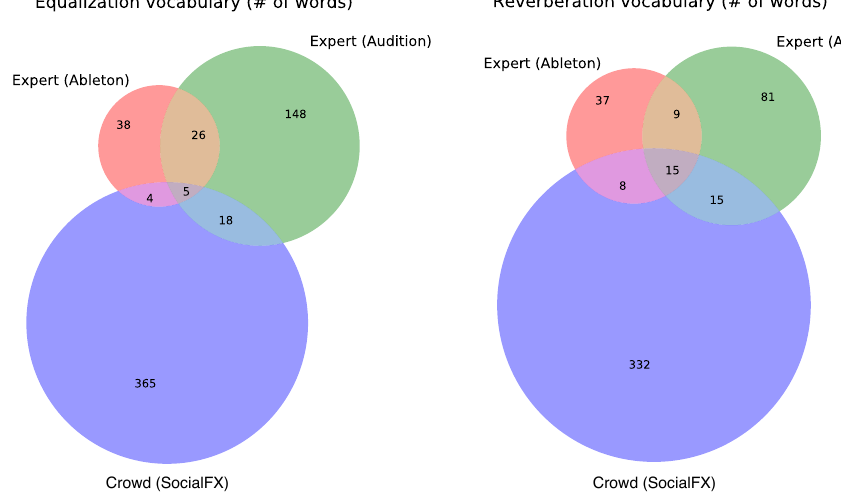
Figure 5. Overlap between three sets of vocabulary for equalization ( left ) and reverberation ( right )—preset vocabulary from Ableton (73 EQ words, 69 reverb words), Audition (197 EQ words, 120 reverb words), and the vocabulary used by a nonexpert population (394 EQ words, 369 reverb words). Figure created by the